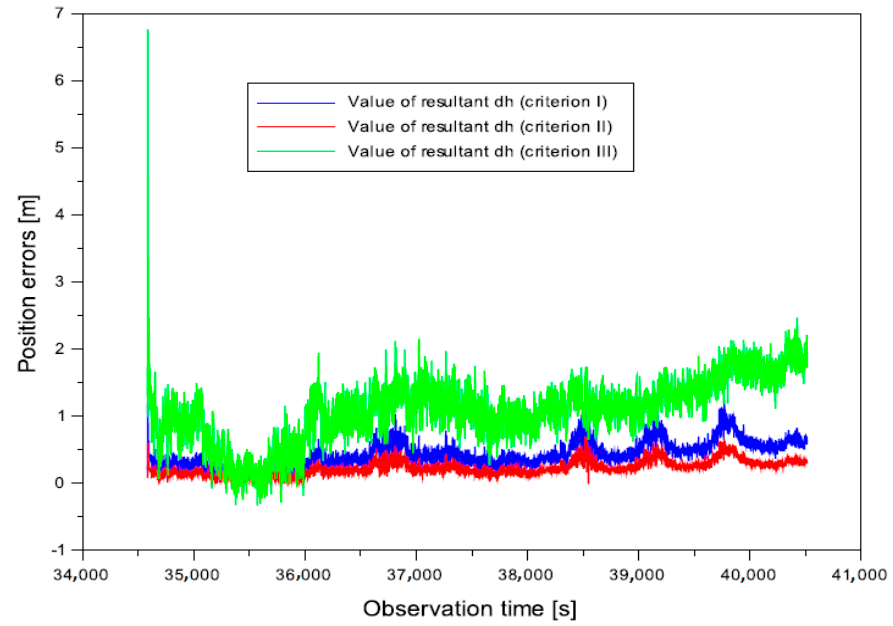
Figure 11. The values of resultant position errors dh .